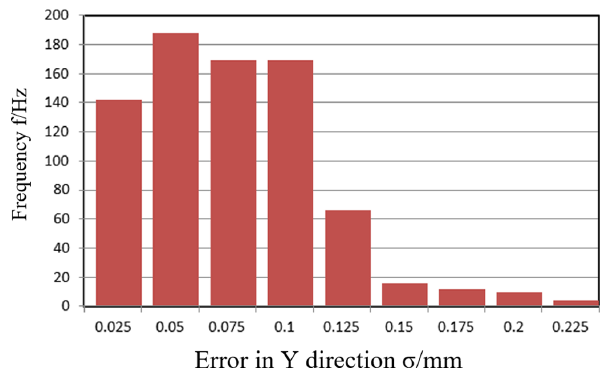
Figure 4. Frequency histogram of position error on working point in (100, 0, 1000) by matrix method.